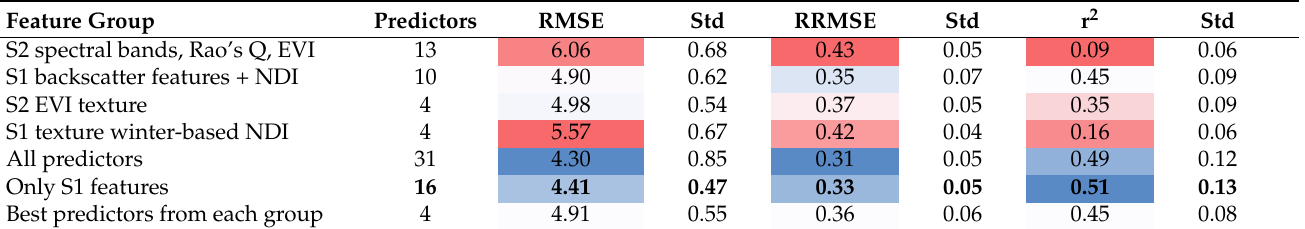
Table 6. Model accuracy metrics (root mean squared error, relative root mean squared error, coefficient of determination) of structural diversity models. The table with heatmap (red = low accuracy, blue = high accuracy) shows the median and standard deviation values summarized over ten model iterations.